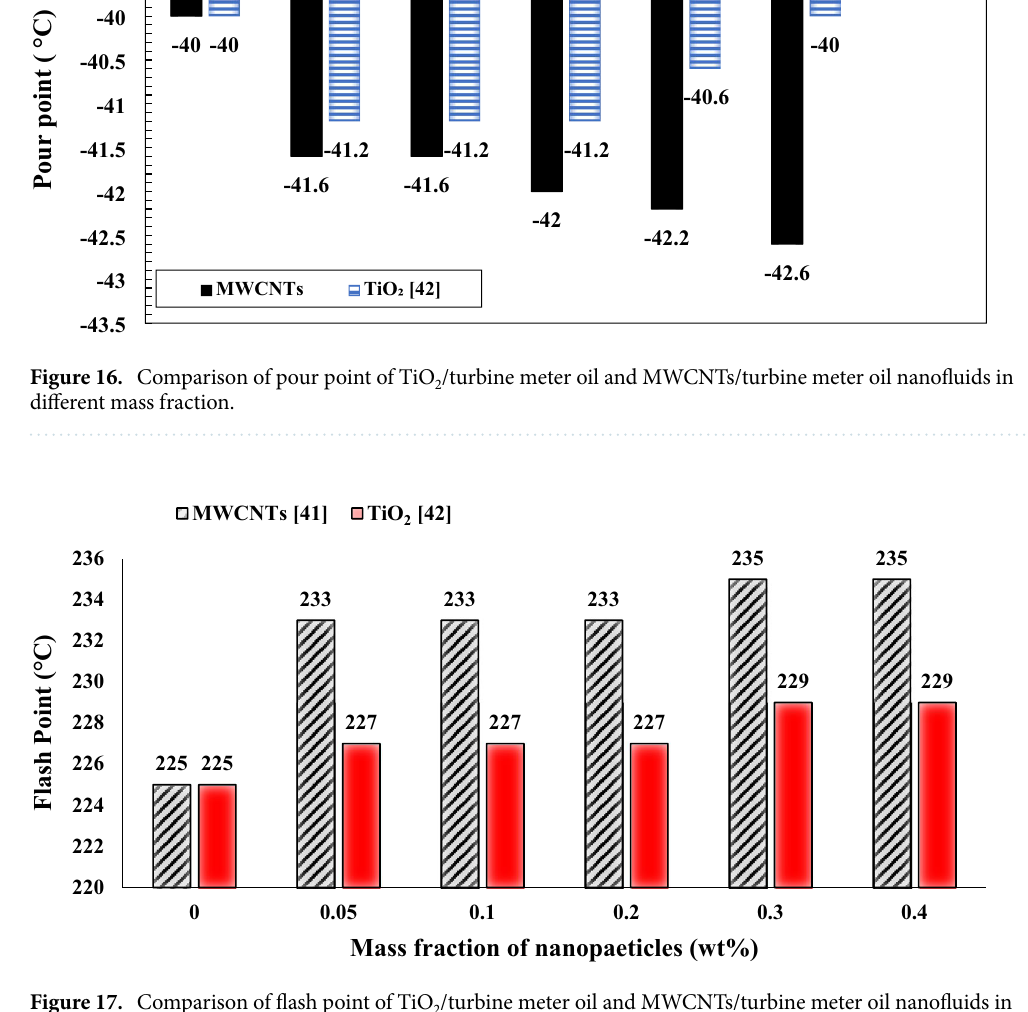
Figure 17. Comparison of flash point of TiO 2 /turbine meter oil and MWCNTs/turbine meter oil nanofluids in different mass